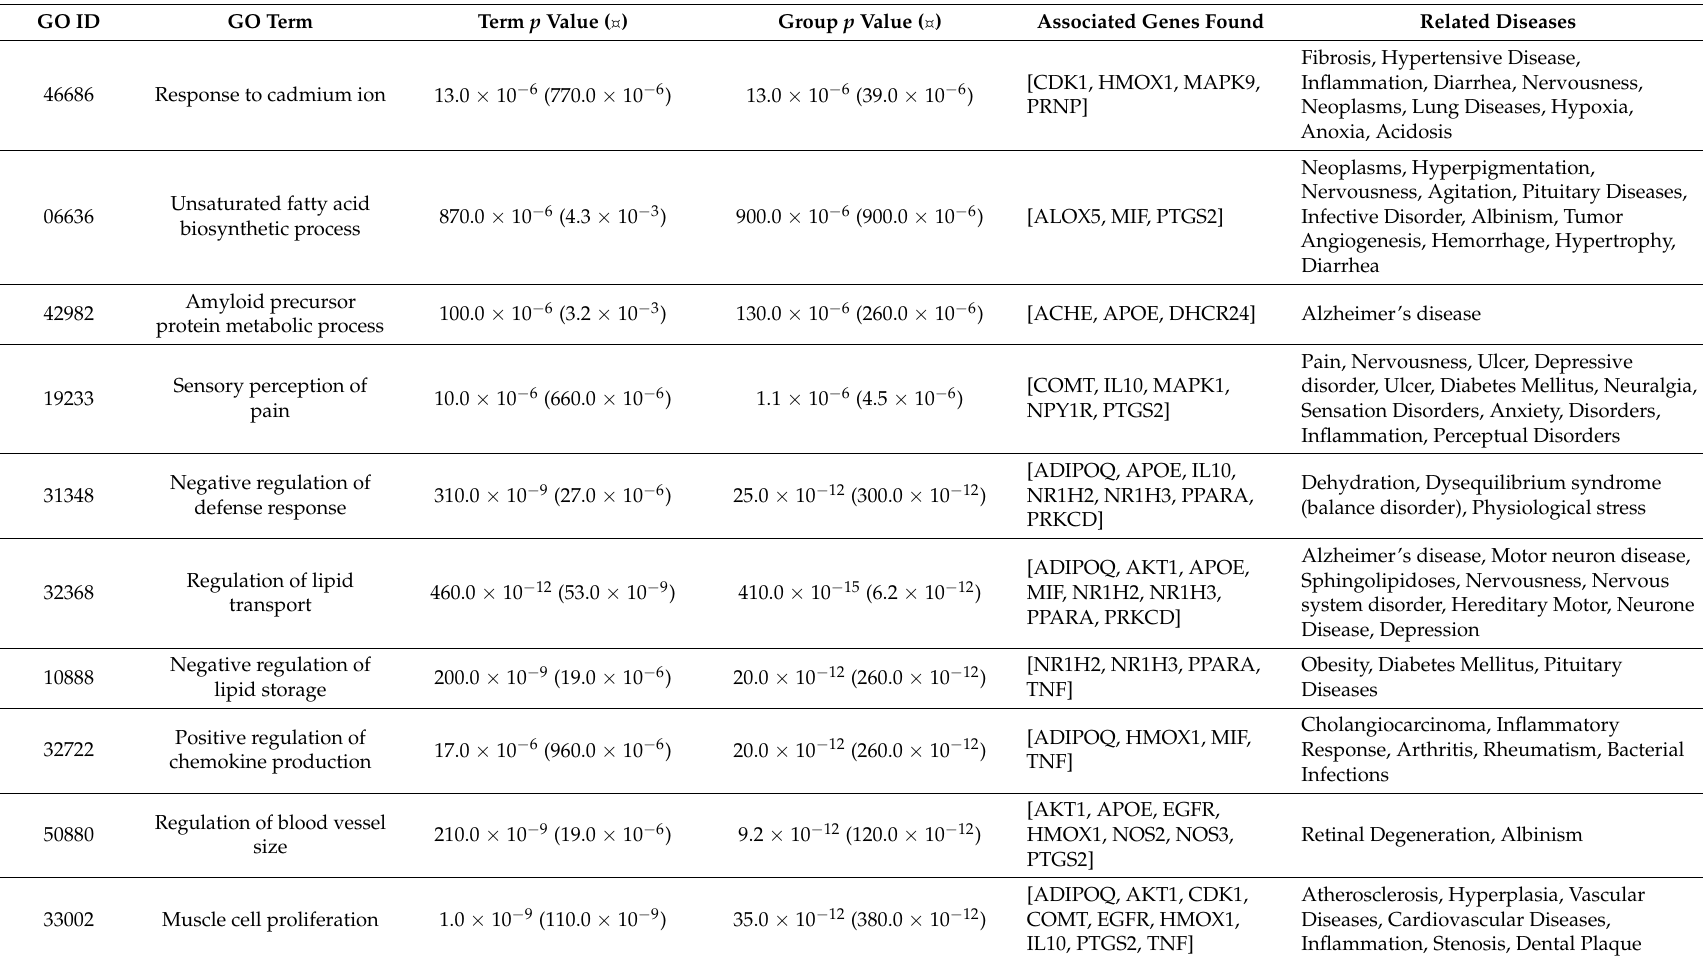
Table 3. Retrieval of GO terms and their related genes via ClueGO.